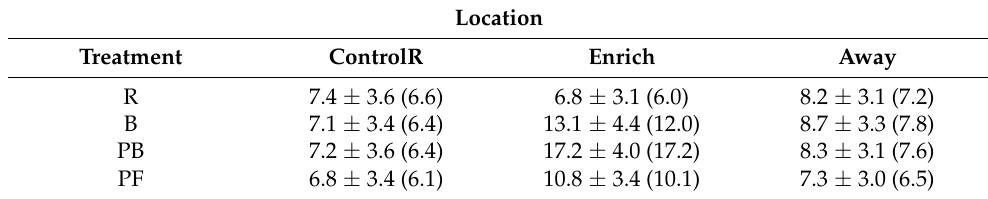
Table 4. The mean ± SD over scans of total counts of birds observed over all behaviours, according to location (1 m diameter around the control ropes (ControlR), the enrichment (Enrich), or away from either (Away)) and enrichment treatment (i.e., ropes (R), bales (B), peck blocks (PB), or pelleted feed (PF)) provided in shed quarters. The estimated means (back-transformed from GLMM) are shown in brackets (which are adjusted for missing